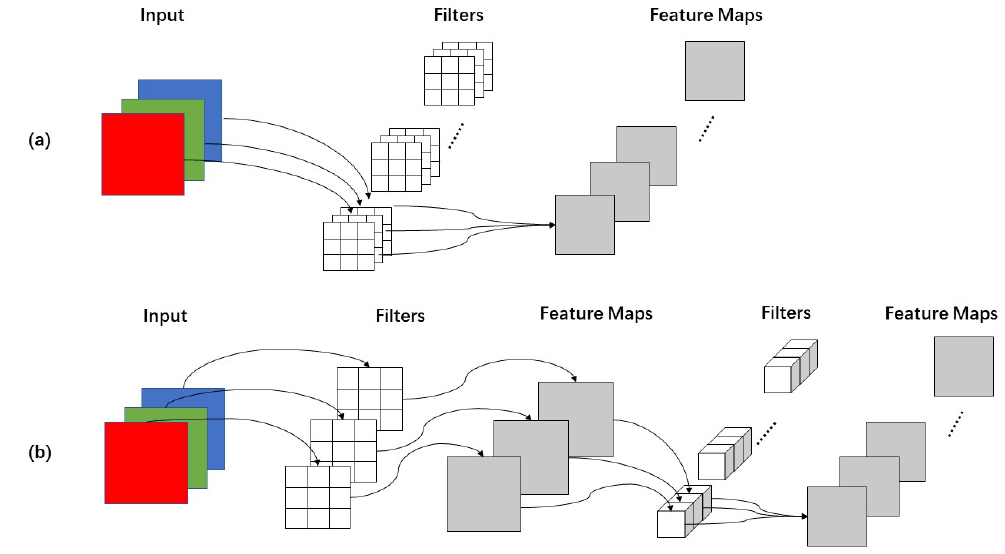
Figure 4. The specific process of convolution. ( a ) standard convolution, ( b ) depth-wise separable convolution.